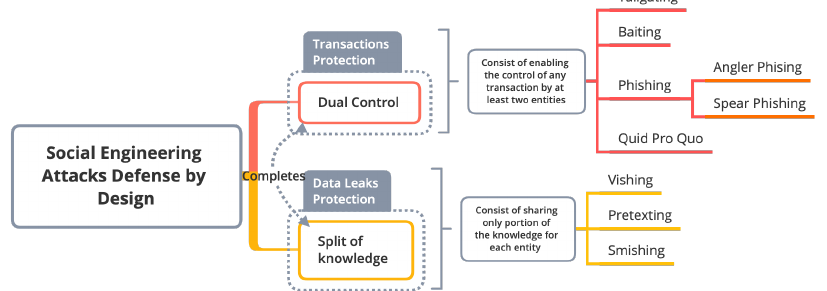
Figure 1. Categorization of SE attacks based on the security principles that prevent it. It describes how the security principle will avoid the associated SE